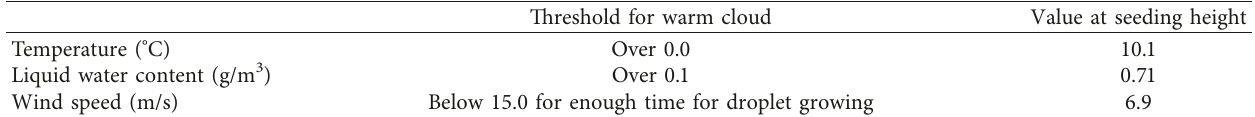
Table 2: The weather condition checklist for cloud seeding experiment on April 25,